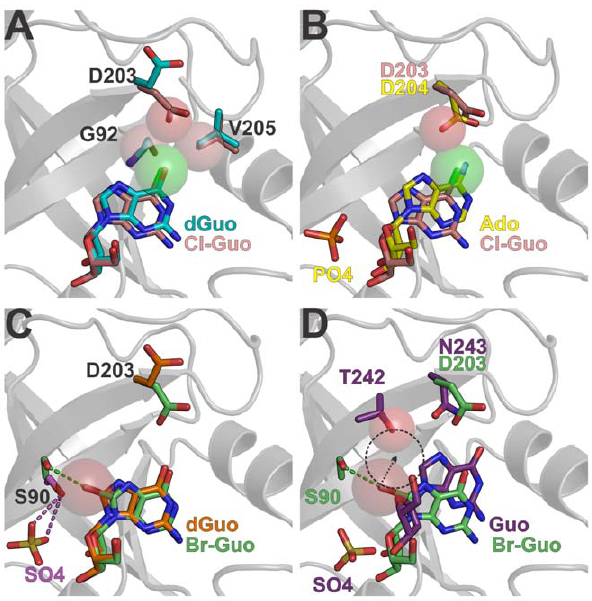
Figure 5. The influence of Cl 6 and Br 8 modifications in catalysis and nucleoside binding. A. Structural alignment of Cl-Guo complex ( pink carbon atoms) and dGuo complex ( cyan carbon atoms). Spheres represent the van der Waals radius of Cl 6 , Gly 92 C a , Asp 203 O d 1 and Val 205 C c 2 atoms. B. Superposition of Cl-Guo complex and EcPNP-Ado- PO 4 complex ( yellow carbon atoms, PDB code 1PK7 [54]). Spheres represent the van der Waals radius of Cl 6 and EcPNP Asp 204 O d 1 atoms to highlight the steric conflict imposed by the Cl 6 atom. C. The Br-Guo complex (carbon atoms in green ), dGuo complex (carbon atoms in orange ) and sulfate complex (carbon atoms in magenta , form IV, chain B) structures are superimposed. The sphere represents the van der Waals radius of Br 8 and the dashed lines represent hydrogen bonds colored according to the respective structures. D. Structural comparison of Br-Guo complex and the trimeric HsPNP-Guo-SO 4 complex ( purple carbon atoms, PDB code 1RFG, [63]). The spheres represent the van der Waals radius of Br 8 and HsPNP Thr 242 O c 1 atoms. The dashed circle has the same radius of Br 8 and indicates the steric clash that would occur if BrGuo was placed at the Guo position in the HsPNP active site.